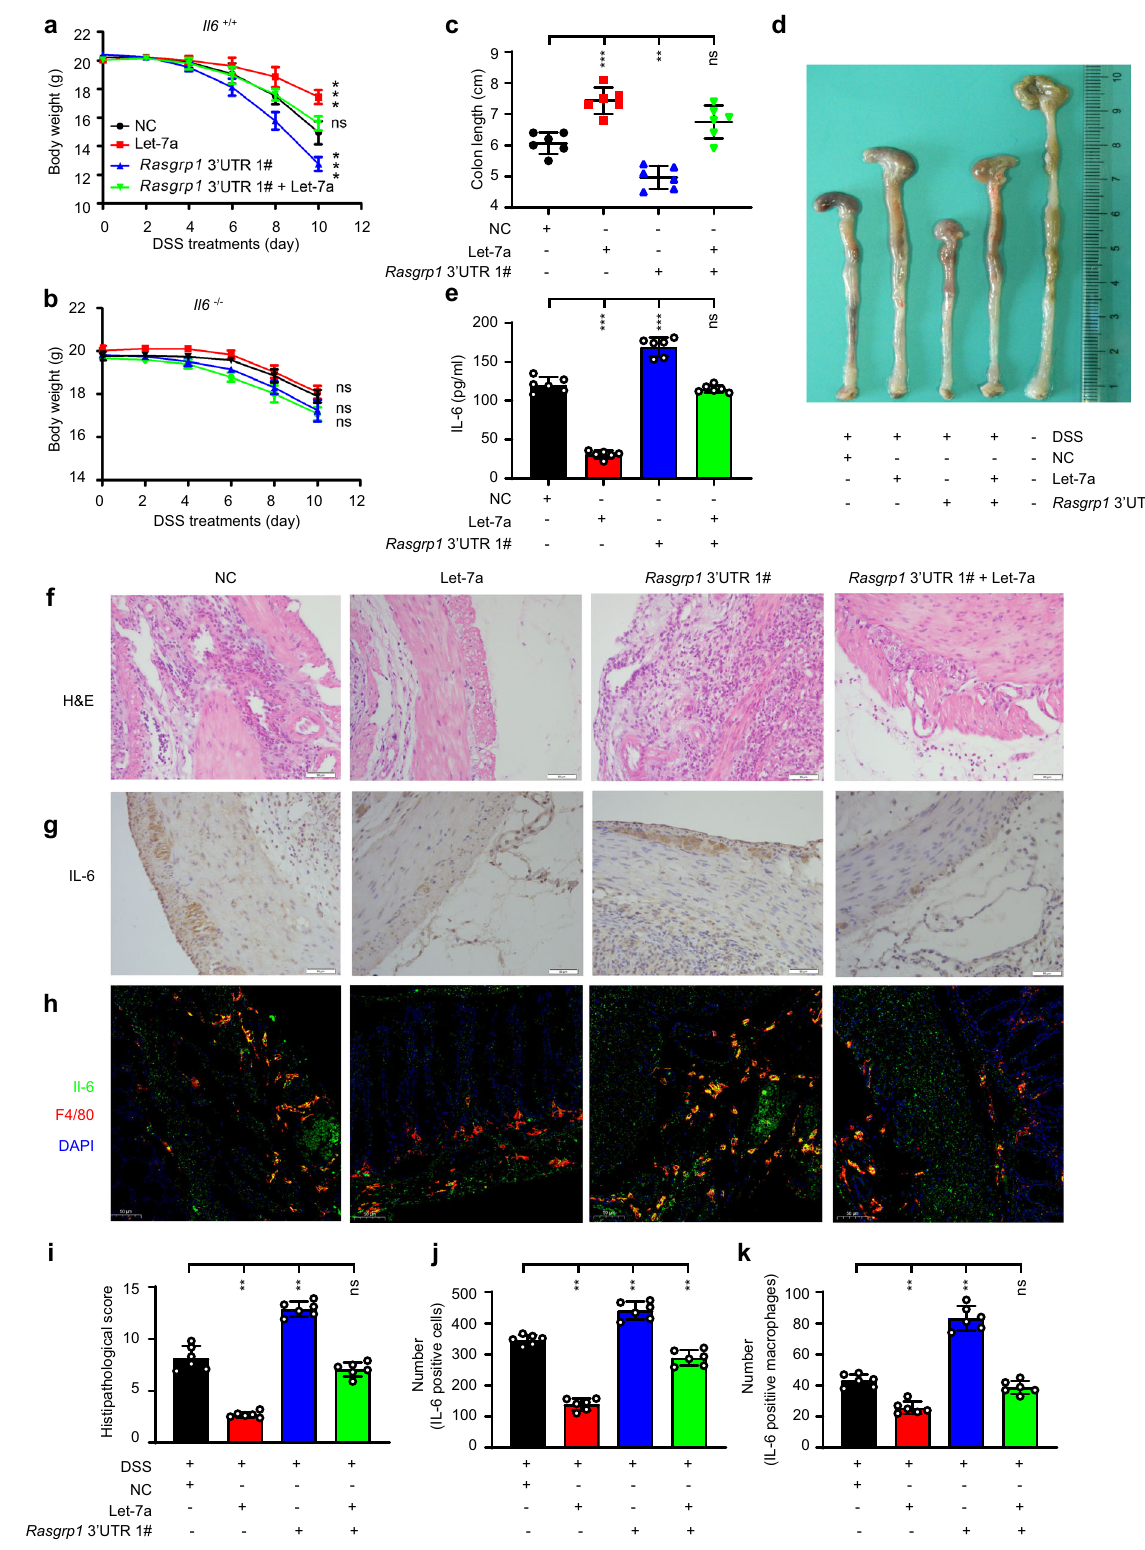
corresponding primers are listed in Supplementary information Table S1. JetPEI transfection reagents (Polyplus Transfection, Ill- kirch, France. Cat: 409-10) were used for the cotransfection of plasmids and miRNAs into HEK293T cells. Gene-speci fi c primer pairs for plasmid construction are listed in Supplementary Table 1.